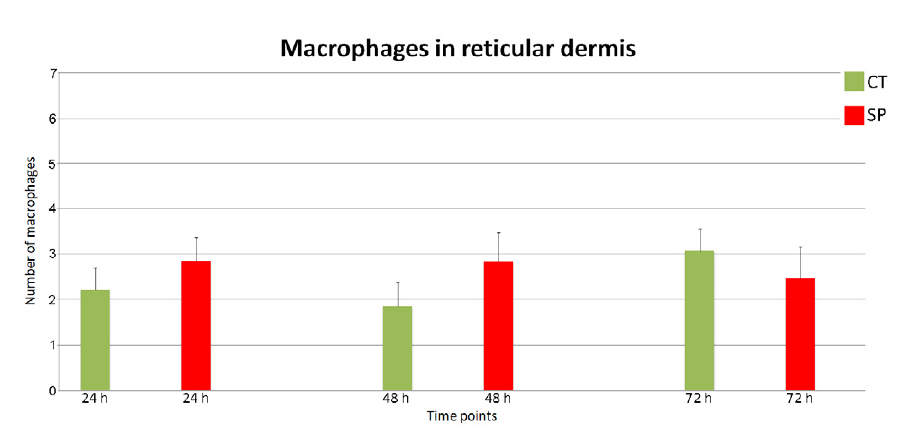
Figure 13. Mean ± standard error values of macrophage number in papillary and reticular dermis.